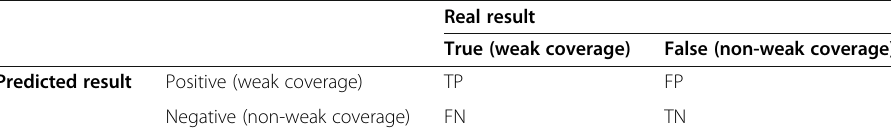
Table 5 Definition of TP, FP, FN, and